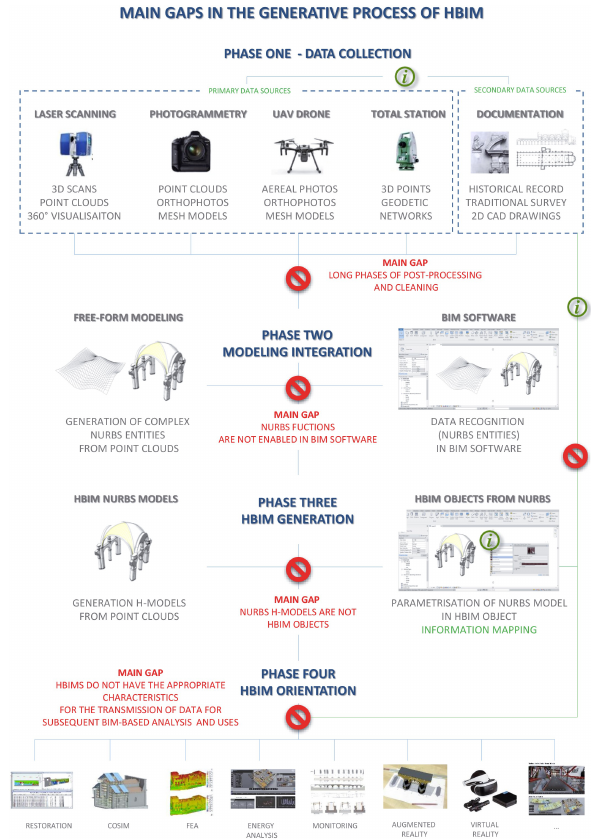
Figure 1. The main gaps in the generative process of HBIM models. The information sharing is hampered due to a lack of modelling tool able to transform point clouds in smart BIM objects (generation) for different type of analysis (orientation).